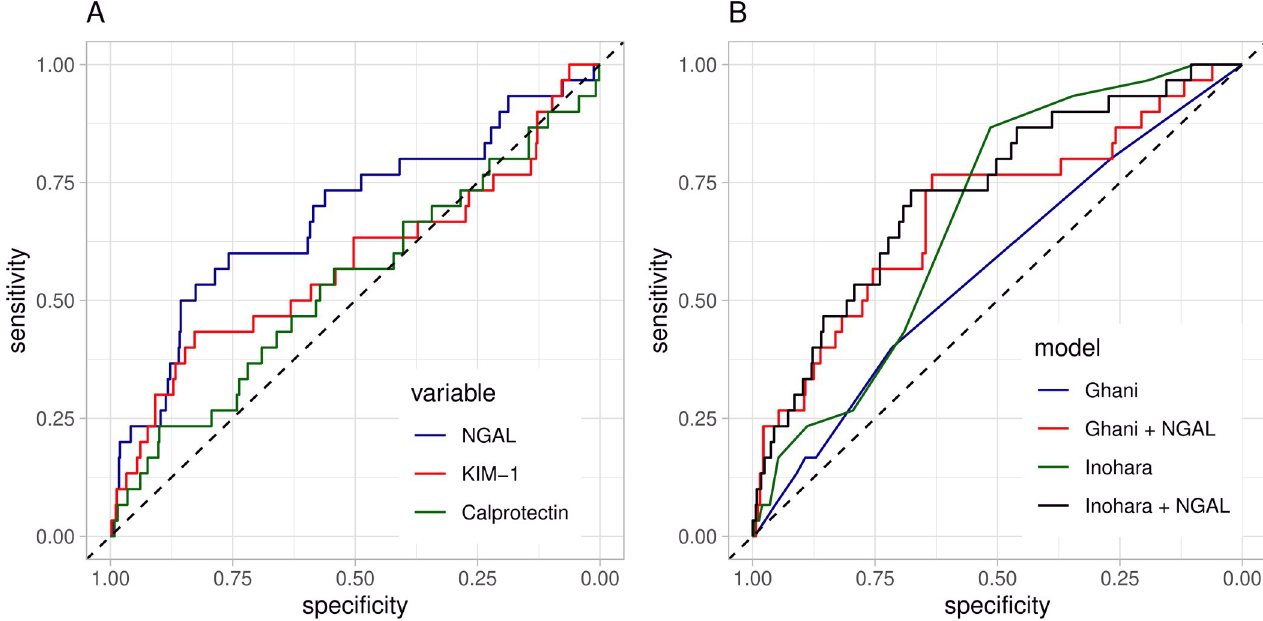
Fig 3. Accuracy of biomarker-creatinine ratios of (A) urinary neutrophil gelatinase-associated lipocalin (NGAL, blue), kidney injury molecule-1 (KIM-1, red) and calprotectin (green) in the prediction of contrast media induced acute kidney injury (CI-AKI) after coronary angiography in receiver operating characteristic (ROC) analysis. The predictive accuracy for CI-AKI in the present study population following the models of Ghani et al. (blue) and Inohara et al. (green) is displayed in (B). ROC curves adding NGAL/creatinine as predictor into the model are displayed in red and black, respectively. AUC–area under the curve. Diagonal scattered lines indicate prediction of CI-AKI by